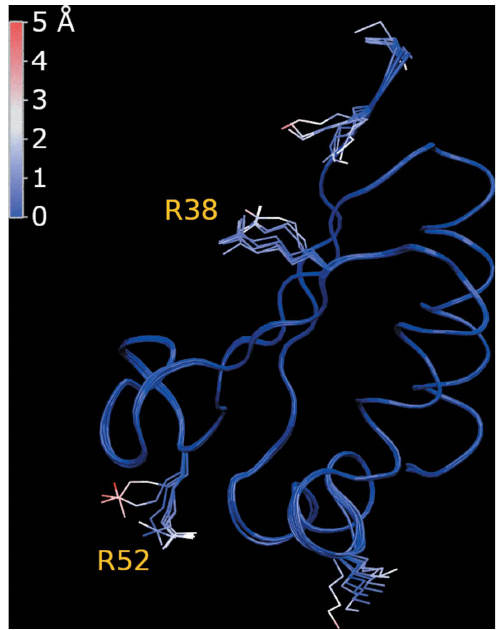
Figure 7 Conformational ensemble of the Amber -refined structure obtained from the D-model with PDB code 1dt4. Eight protein molecules in the simulated UC are superimposed via the C (cid:2) atoms of the secondary- structure regions. The individual structures are colored according to the deviation from the mean coordinates. Only those side chains where the deviation reaches 2.5 A˚ are visualized in the plot. Additionally, those side chains that sample different rotameric states (according to Lovell et al. , 2000) are labeled in the plot. As expected, the refined S-model displays a somewhat greater amount of conformational heterogeneity compared with the refined D-model (results not